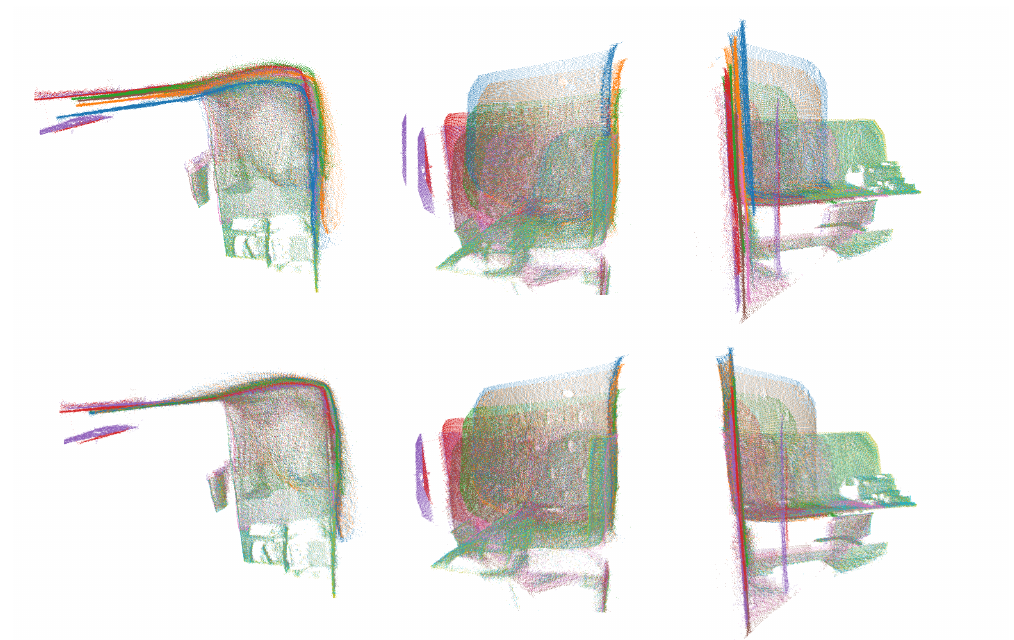
Figure 6. Several views of a reconstructed scene: ( top ) before optimization; ( bottom ) after optimization. Point clouds corresponding to each capture are colored differently for better